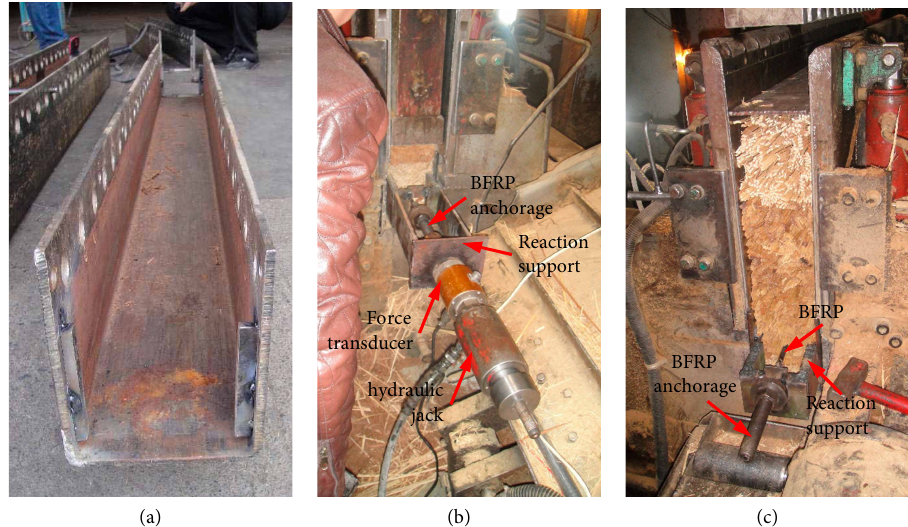
Figure 2: Prestressing tension system: (a) steel mould for bamboo beam, (b) tensioned end, and (c) fixed end.